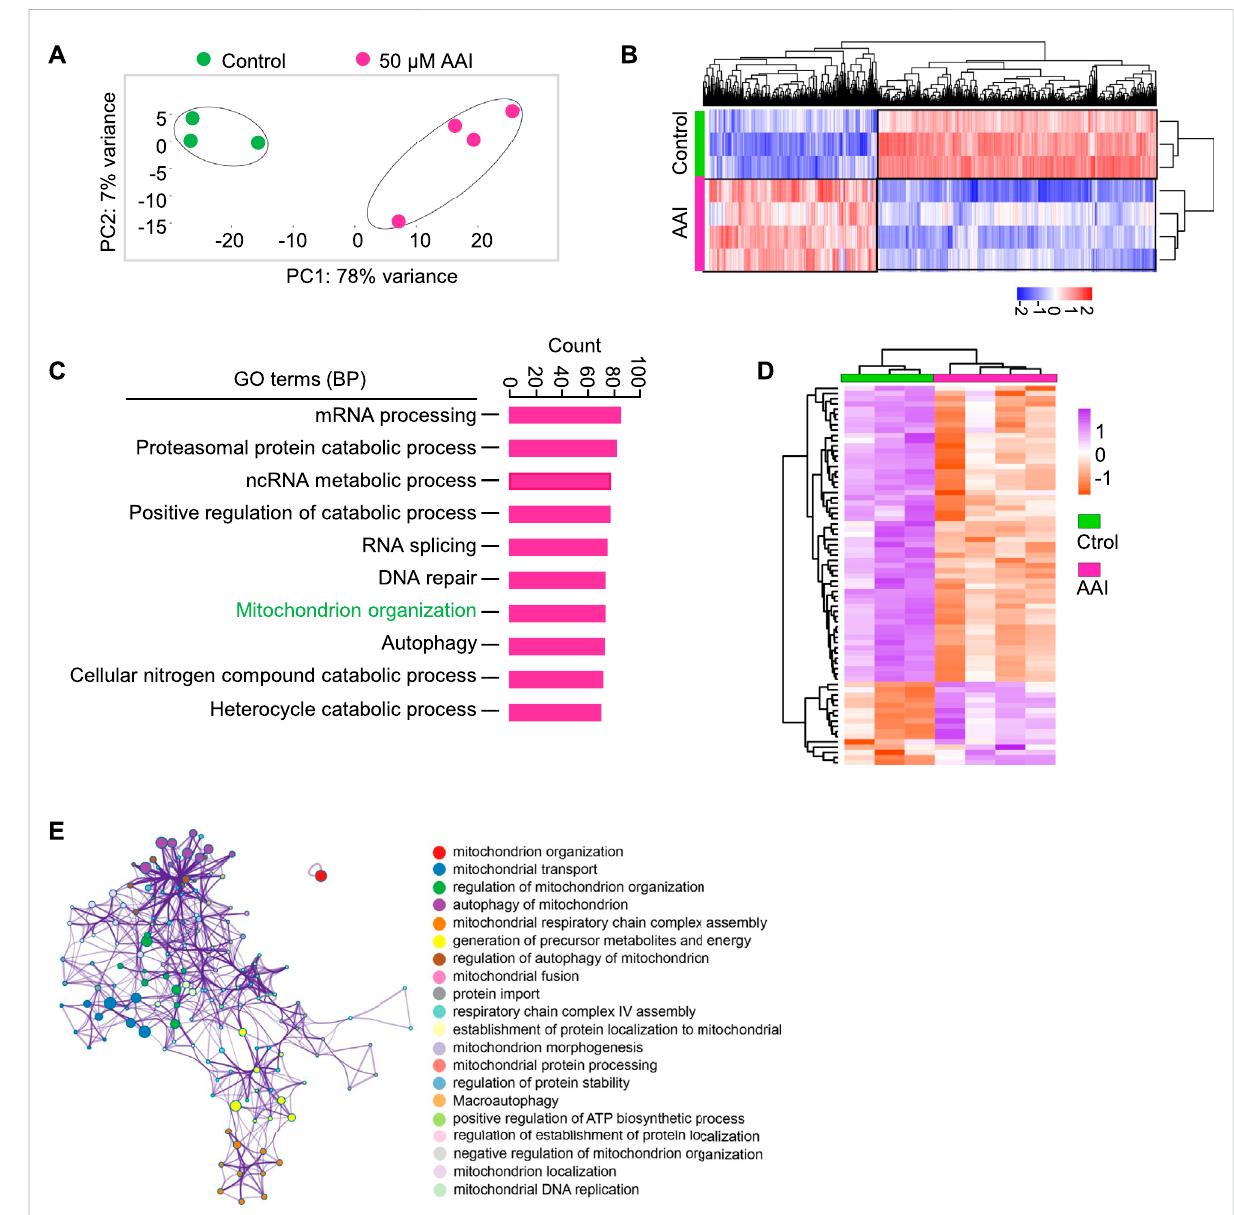
AAI exposure alters the expression levels of genes involved in mitochondrion organization. (A) The GV oocytes were matured in the M16 medium containing 0 or 50 μ M AAI for 8 h to reach MI stage. The oocytes were collected for RNA-Seq. PCA analysis of RNA-seq data grouped controls and AAI treatments into two separate clusters. Each data point represents one experiment. The correlation coef fi cient is 0.99 and 0.97 between three repeats in control and four repeats in AAI treatment, respectively. (B) The heatmap of DEGs between the control and AAI- exposedgroups. (C) Thetop10GO-BPtermsofDEGs. (D) TheheatmapofDEGsenrichedinmitochondrionorganizationin (C) . (E) Theannotationof DEGs for mitochondrion organization in (D)